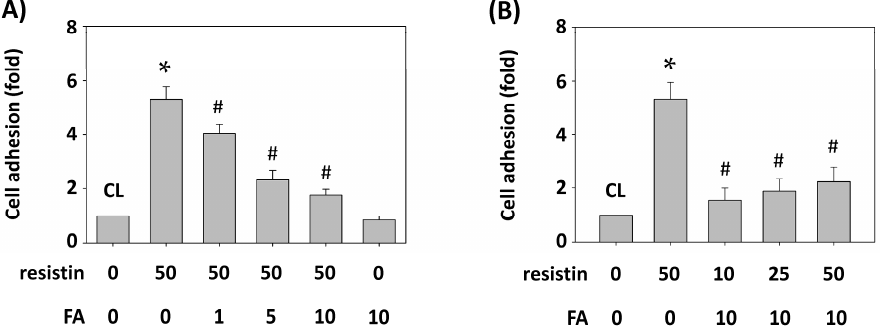
Figure 5. FA inhibits resistin-initiated HCT-116 cell adhesion to HUVECs. ( A ) HCT-116 cells were pretreated with FA at 0, 1, 5 and 10 μ g/mL and then were maintained as control or stimulated with resistin; ( B ) HCT-116 cells were pretreated with FA at 0 or 10 μ g/mL and then were maintained as control or stimulated with resistin at 10, 25 and 50 ng/mL. HCT-116 cell adhesion was determined. Data represent the mean ± SEM from three independent experiments. * p < 0.05 vs. control cells; # p < 0.05 vs. cells treated with resistin only.